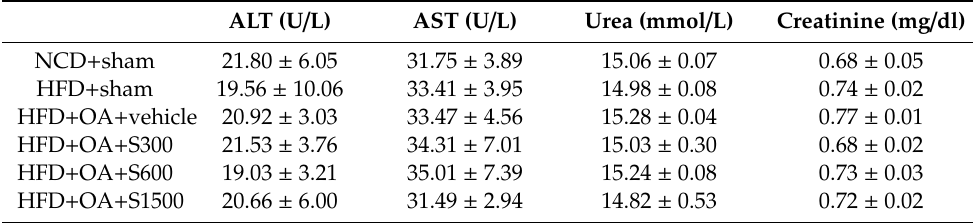
Figure 3. E ff ects of Shiikuwasha Extract (SE) on lipid profiles. ( A ) TG, ( B ) TC, ( C ) LDL-C, ( D ) HDL-C in the NCD + Sham, HFD + Sham, vehicle, S300, S600, and S1500 groups. Values are expressed as means ± SEM ( n = 6). * p < 0.05 when compared to the NCD + sham group; # p < 0.05 when compared to the HFD + sham group; + p < 0.05 when compared to the vehicle group. The letters were calculated by one-way ANOVA and Duncan’s multiple range test. Table 1. Effects of Shiikuwasha Extract on liver and kidney function.